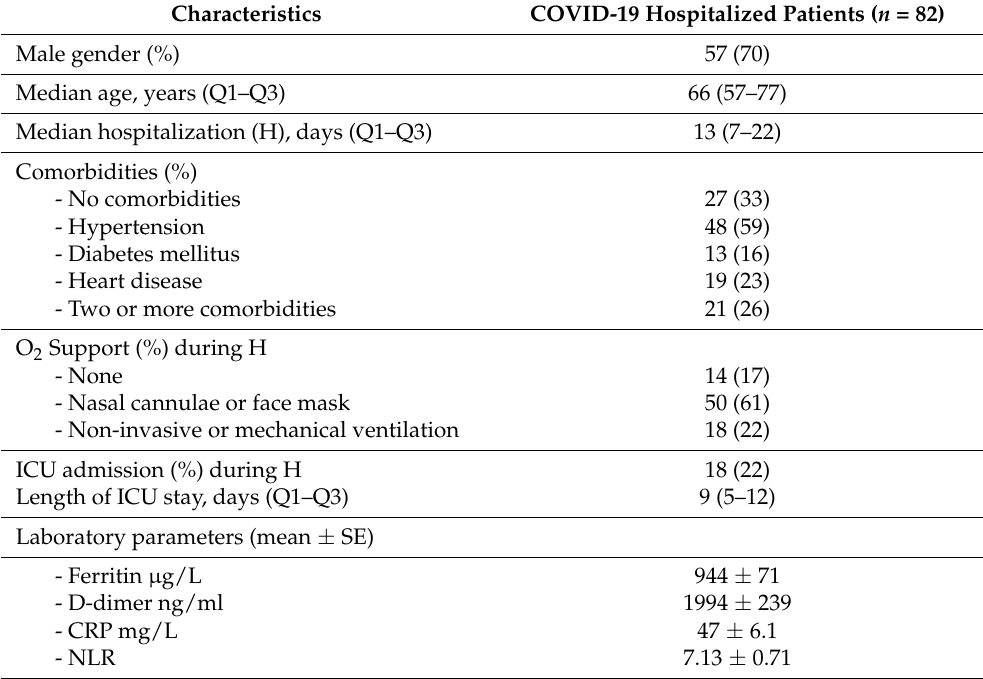
Table 1. Characteristics of included